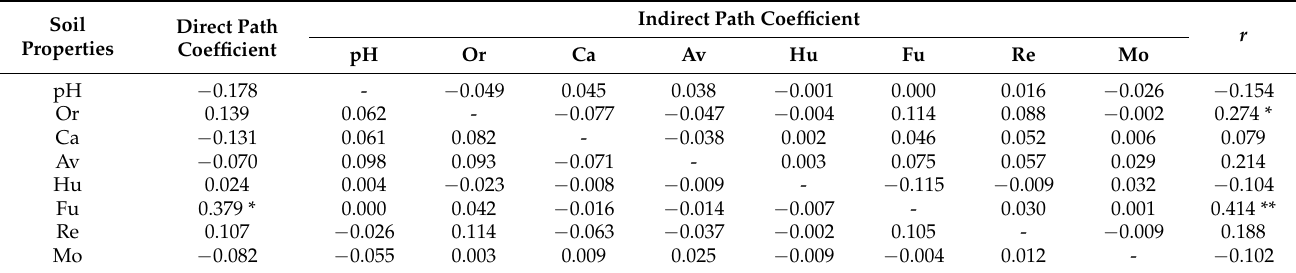
Table 2. Path analysis between soil properties and